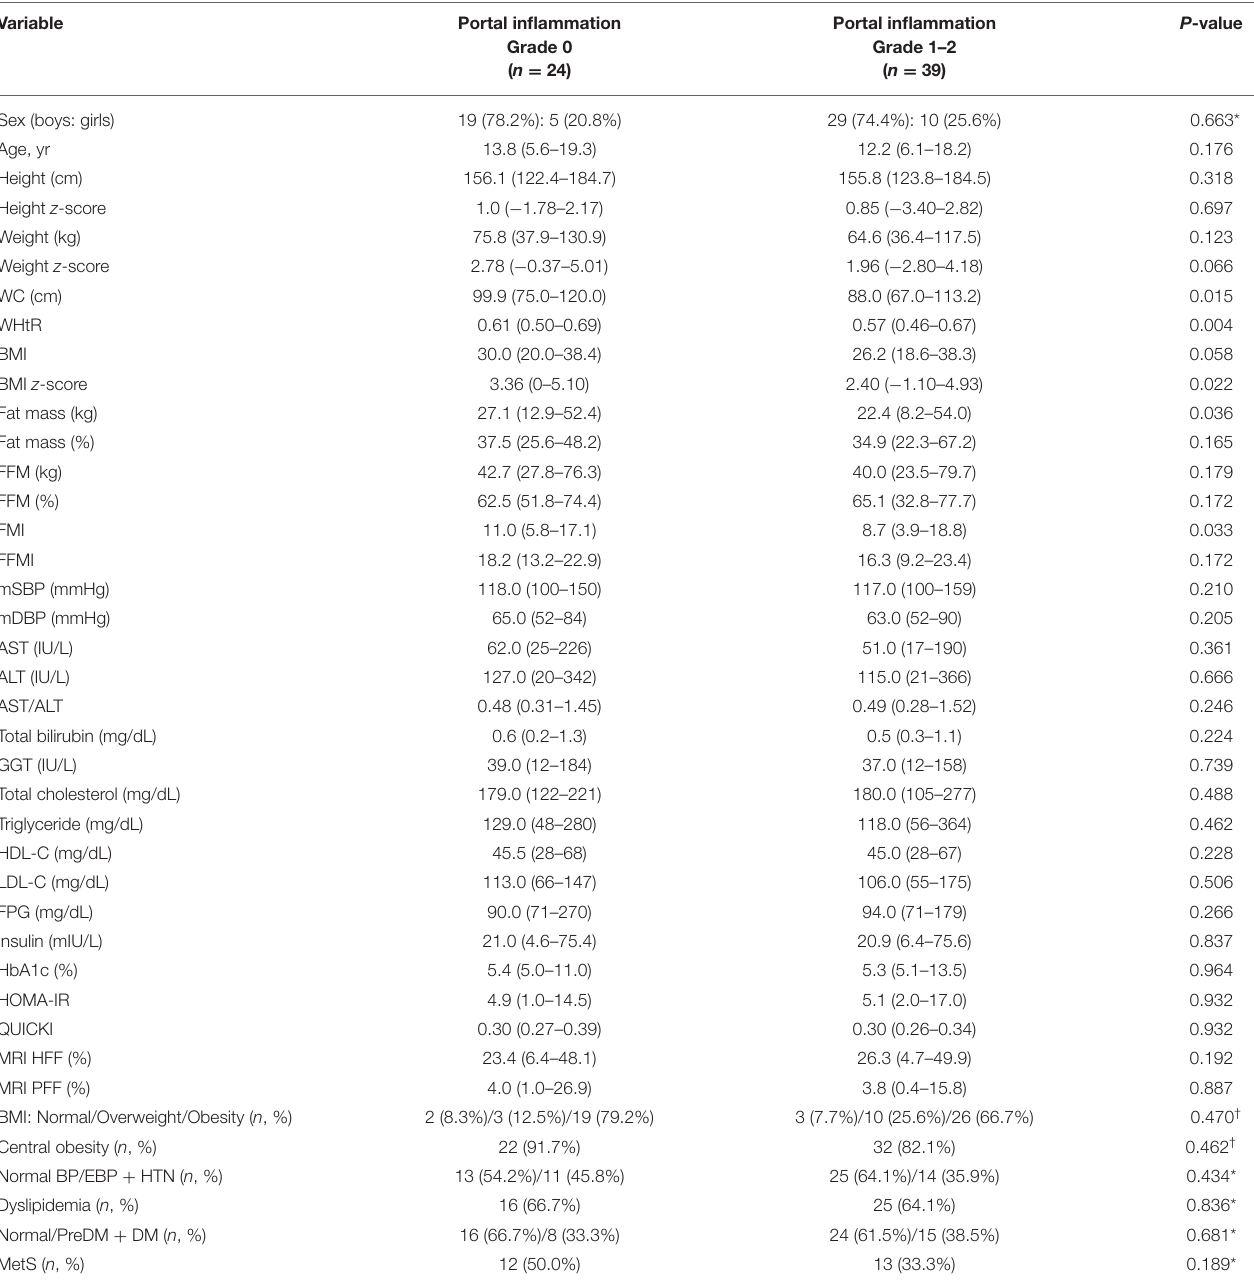
TABLE 6 | Comparison of demographic, anthropometric, laboratory, and magnetic resonance imaging-measured fat fraction findings of 63 children with non-alcoholic fatty liver disease by liver histologic portal inflammation grade.